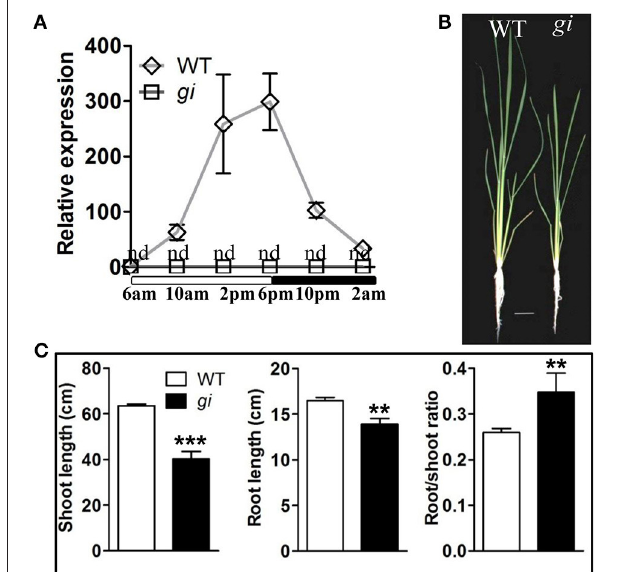
FIGURE 1 | Characterization of the growth phenotype of WT and osgi plants. (A) Expression of OsGI in WT and osgi (gi) plants throughout the day. Unfilled and filled bars below the x-axis indicate times of lights-on and lights-off, respectively. Gene expression was normalized to the expression level of OsACTIN . (B) WT and osgi plants were grown hydroponically under normal growth conditions for 30 days. (C) Shoot length, root length and root/shoot ratio of WT and osgi plants. All data represent the mean of three biological replicates, with error bars indicating SD. Significant differences relative to the corresponding WT strain are indicated with asterisks ( *** P < 0.001; and ** P < 0.01). Bars = 4cm. nd, not detectable.